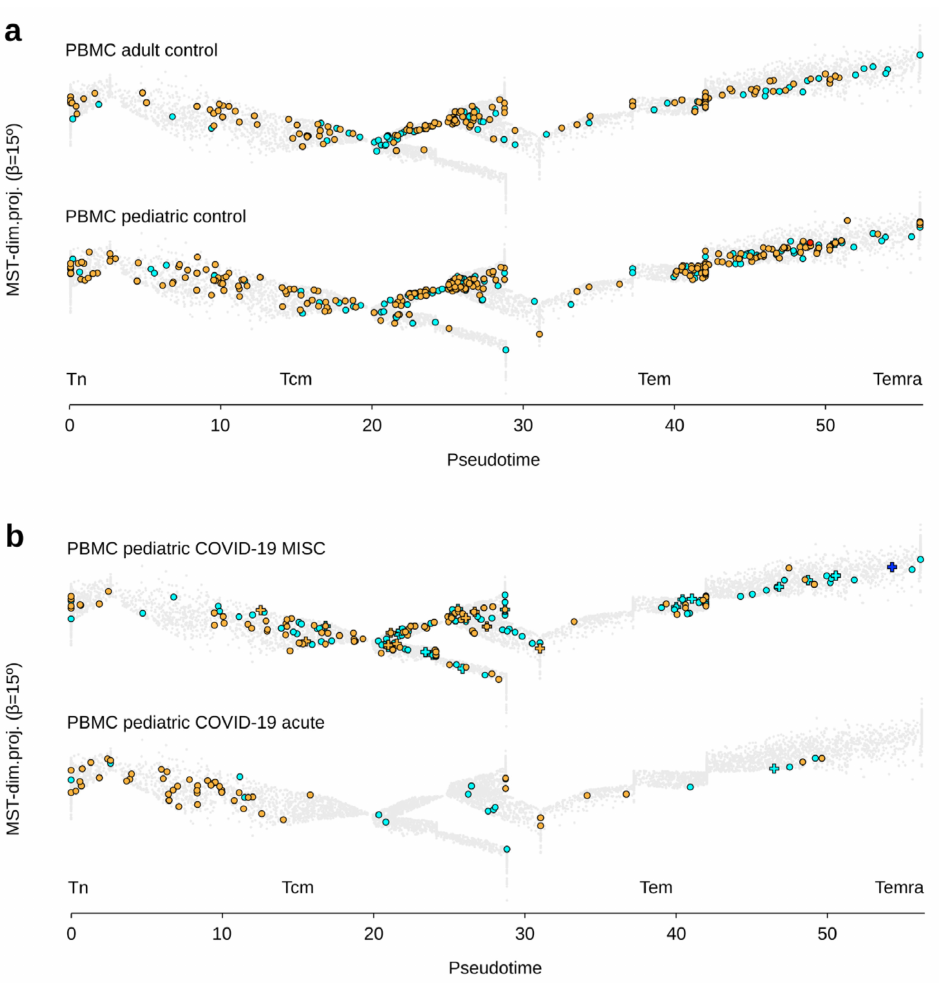
Figure 4. Differentiation and functional hallmarks of γδ T lymphocytes from pediatric COVID- 19 patients. ( a ) PBMC-derived γδ T lymphocytes from adult and pediatric controls. ( b ) PBMC- derived γδ T lymphocytes from pediatric COVID-19 patients with either MIS-C or acute disease. (Representative examples overlaid on the public trajectory of γδ T lymphocyte differentiation, same legend key as in Figure